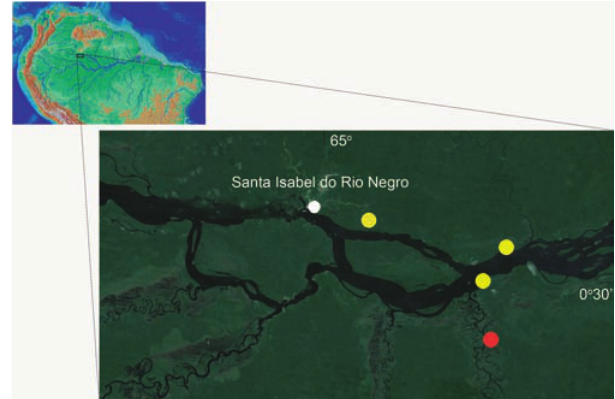
Fig. 5. Map of northern South America and surroundings of Santa Isabel do Rio Negro, rio Negro basin (detail), showing the distribution of Priocharax nanus . Type locality (red dot), other localities (yellow